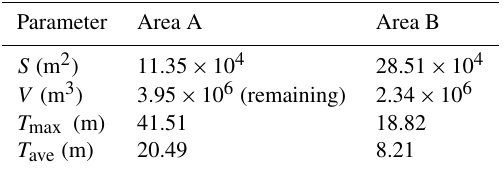
Table 3. Geometric parameters of the flowslide (area and thickness).